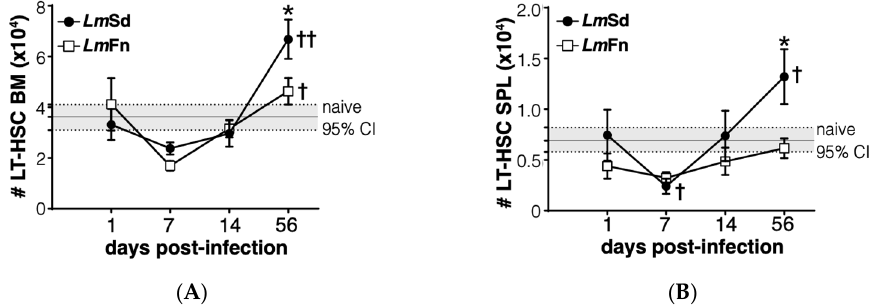
Figure 5. Long-term HSC-like cells display biphasic kinetics in bone marrow and spleen of Lm Sd- infected mice. Number of cells expressing LT-HSC markers in ( A ) bone marrow and ( B ) spleen at various time points. Graphs represent compiled results (mean ± SEM) from at least 4 independent experiments for each time point, with n = 13, n = 11, n = 11, and n = 15 mice per group ( Lm Fn vs. Lm Sd) at 1-, 7-, 14-, and 56-days post-infection, respectively. The grey horizontal line and shaded area represent mean ± 95% confidence interval for naïve control mice. * p < 0.05 comparing infection with Lm Fn vs. Lm Sd at a given time point and †, †† p < 0.05 comparing infected groups ( Lm Fn or Lm Sd) to naïve control mice. See also Supplementary Figure S2 for flow cytometry gating strategies and representative